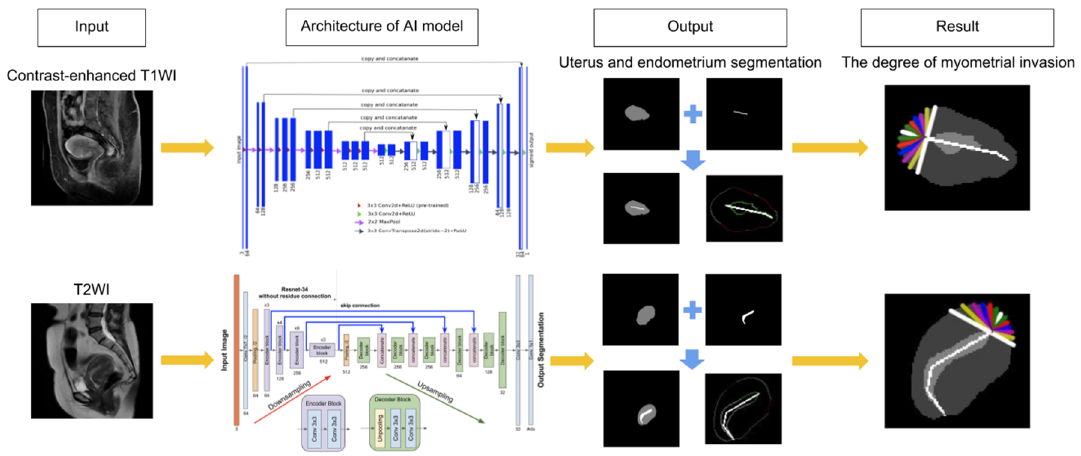
Figure 3. Consecutive steps of MR image analysis include image upload, interpretation of image by AI, and diagnosis output. The architecture of our AI model includes convolutional neural networks consisting of convolution layers, max pooling layers, and a fully connected layer. Each layer extracts different image features; subsequently, all of the extracted features are integrated. The result includes the depth of myometrial invasion and stage classification (FIGO stage IA or IB). Table 2. Accuracy rates of AI and